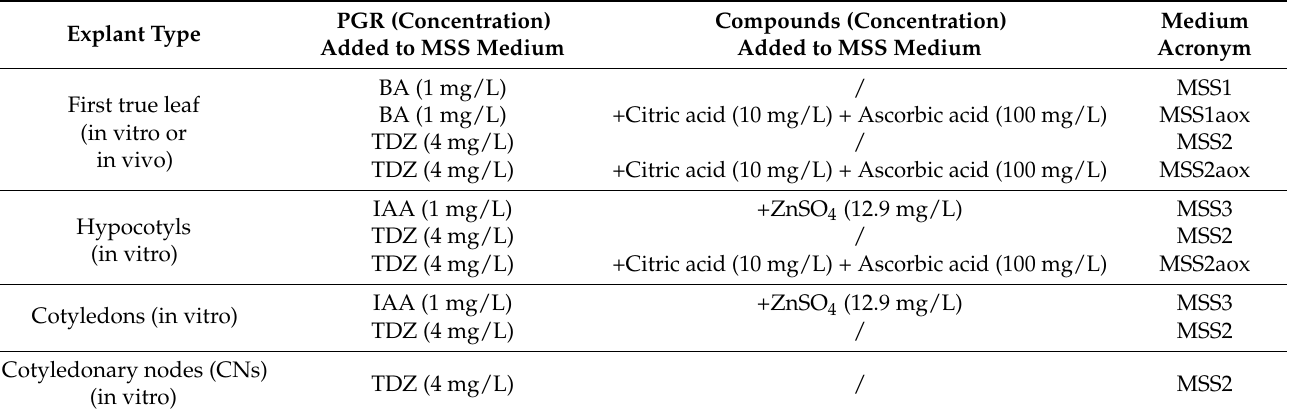
Figure 1. Ocimum basilicum FT Italiko: ( a ) leaf cultured on MSS1; ( b ) hypocotyls cultured on MSS3; ( c ) cotyledons cultured on MSS2; ( d ) CN cultured on MSS2. (MSS = shoot multiplication medium B; CN = cotyledonary node). Scale bar = 0.5 cm. Table 1. Starting plant materials and media composition used in the regeneration experiments. Basal medium MSS with 3% sucrose has been used as control.